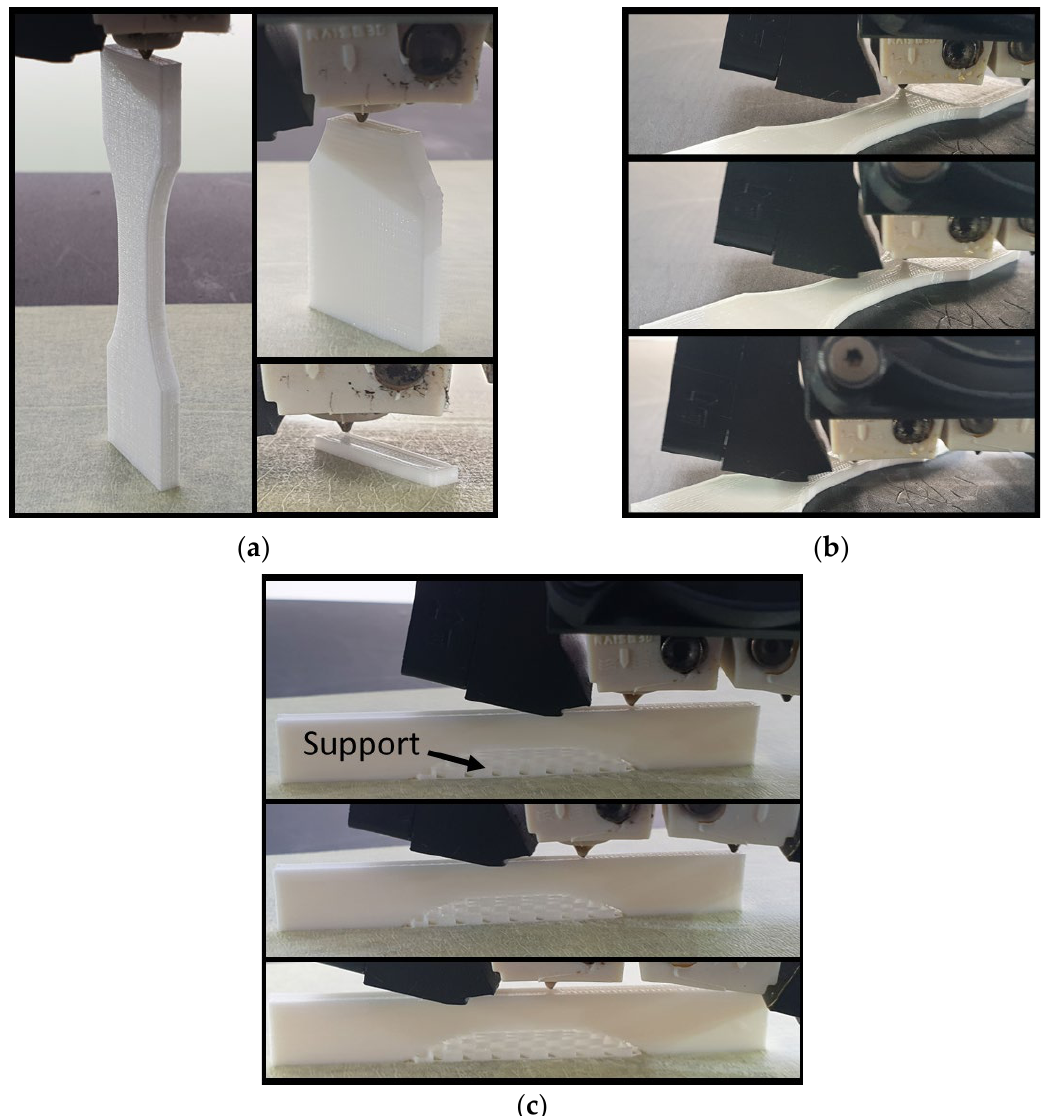
Figure 2. Ongoing 3D printing of PLC showing the three-part orientations: ( a ) vertical, ( b ) horizontal, and ( c ) lateral configurations.